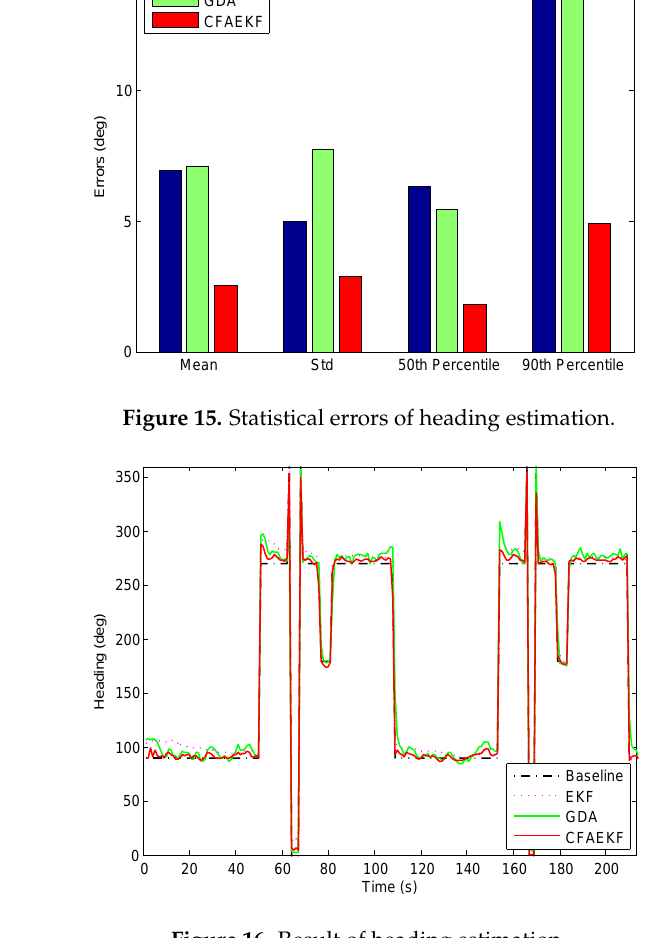
Figure 16. Result of heading estimation.